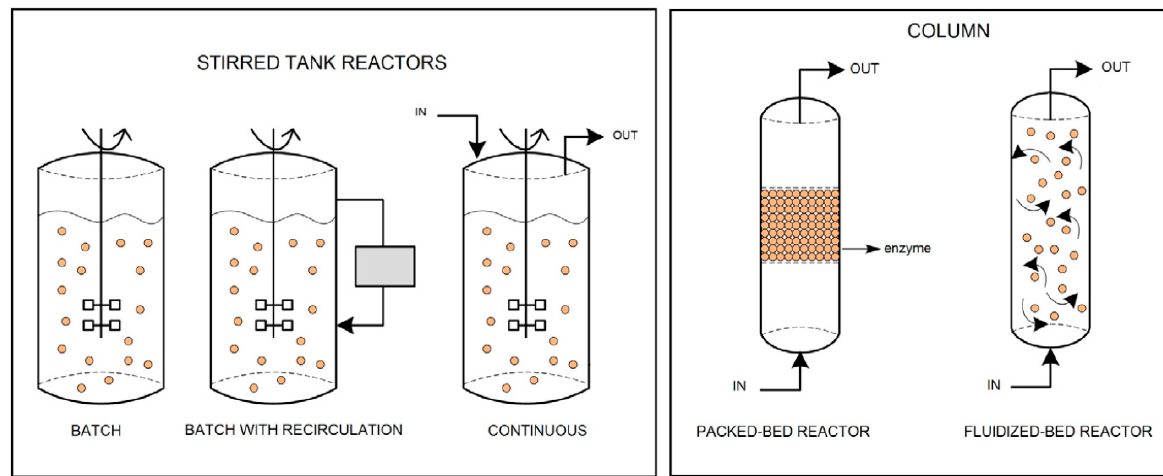
Figure 2. Schematic representation of the main types of bioreactors: left —stirred tank reactors, right —column reactors [62].